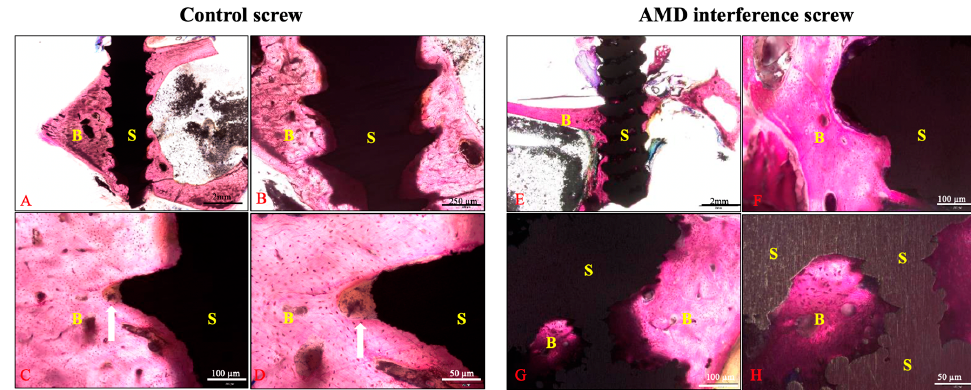
Figure 6. Histological examination of the bone–screw interface between groups. The specimens were stained with Sanderson’s Rapid Bone Stain and then counterstained with acid fuchsin. Figures A – D represented the controlled screw from scale of 12.5×, 40×, 100×, and 200×, respectively. The surface of the controlled screw was sharp and healed with fibrous tissue at the tip of screw thread. The AMD screw group ( E – H ) exhibited a rougher surface and superior bone–screw integration on the screw surface and inside the screw body. Line arrows indicate fibrous tissue healing at the tip of the control screw thread; B: bone, S: screw.